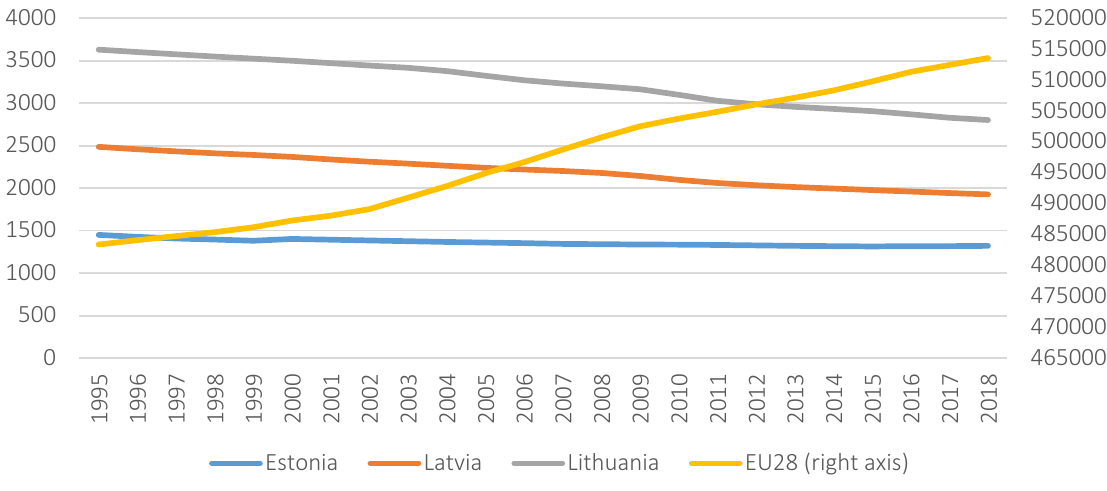
Figure 2. Population dynamics in the Baltics and EU28, thousands